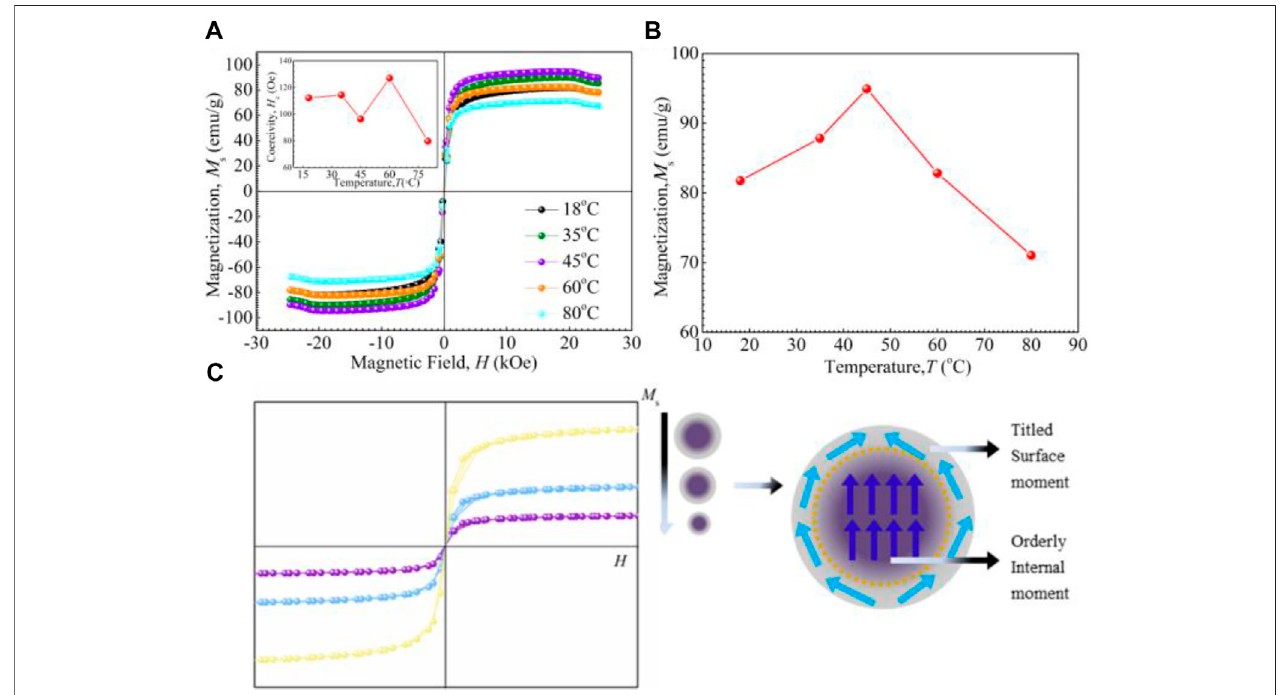
FIGURE 4 | Magnetic properties of Fe 3 O 4 nanoparticles prepared at different temperatures: (A) hysteresis loops, (B) preparation temperature dependence of magnetization M s , (C) schematic illustration of the moment alignment of a magnetic nanoparticle.